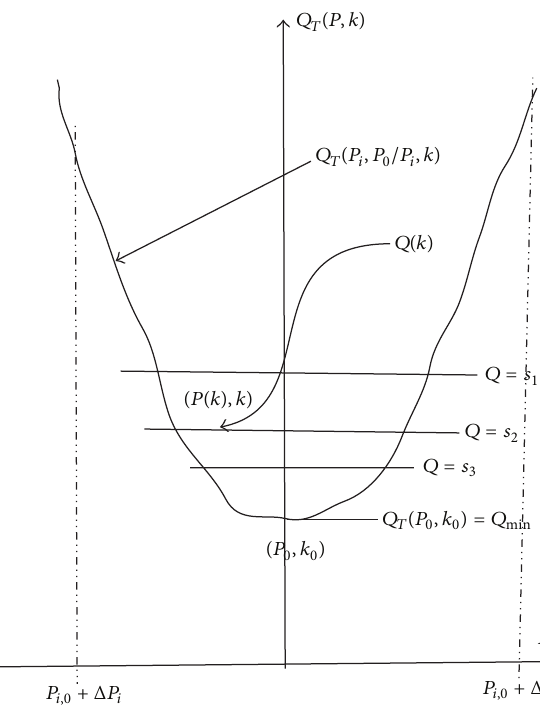
Figure 1: Depiction of how the 𝑘 variation optimizing 𝑄 leads to a solution on a level surface of the 𝑄 𝑇 function where 𝑄 𝑇 ≤ 𝑄